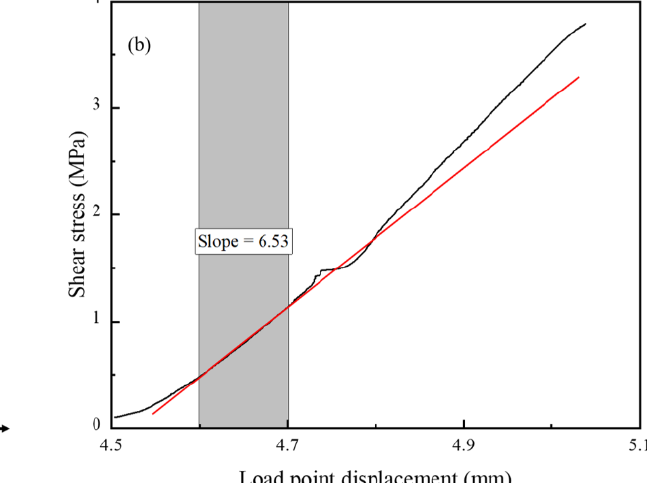
4 of 13 Figure 2. Fault block slip experiment. ( a ) Shear test apparatus (LVDT: Linear Variable Displacement Transducer). ( b ) Schematic diagram of loading method.